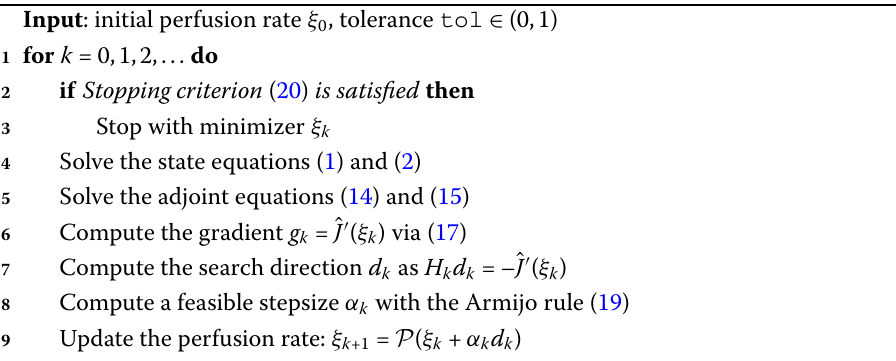
Algorithm 1: Projected quasi-Newton